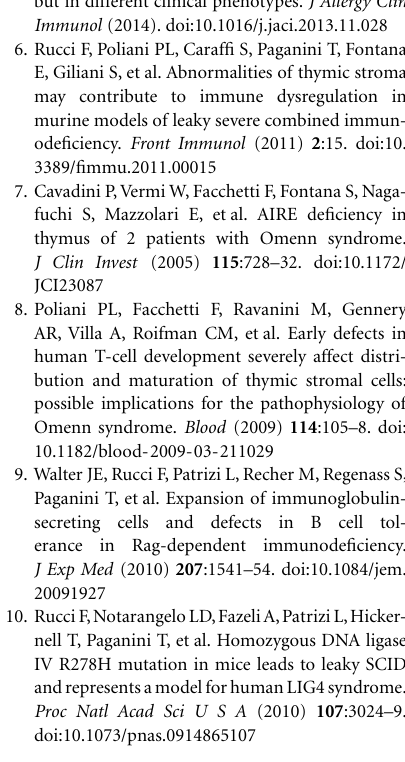
positive (ISP), followed by CD3 + CD4 + CD8 + double positive (DP) and finally into CD3 + CD4 + or CD3 + CD8 + single positive (SP) cells while passing through the cortex and the medulla. (B) HumanT-cell differentiation stages includingV(D)J recombination bars (14) and genetic defects underlying PID that result in impaired precursor differentiation.The indicated developmental blocks largely rely on data from targeted mutation studies in the mouse.